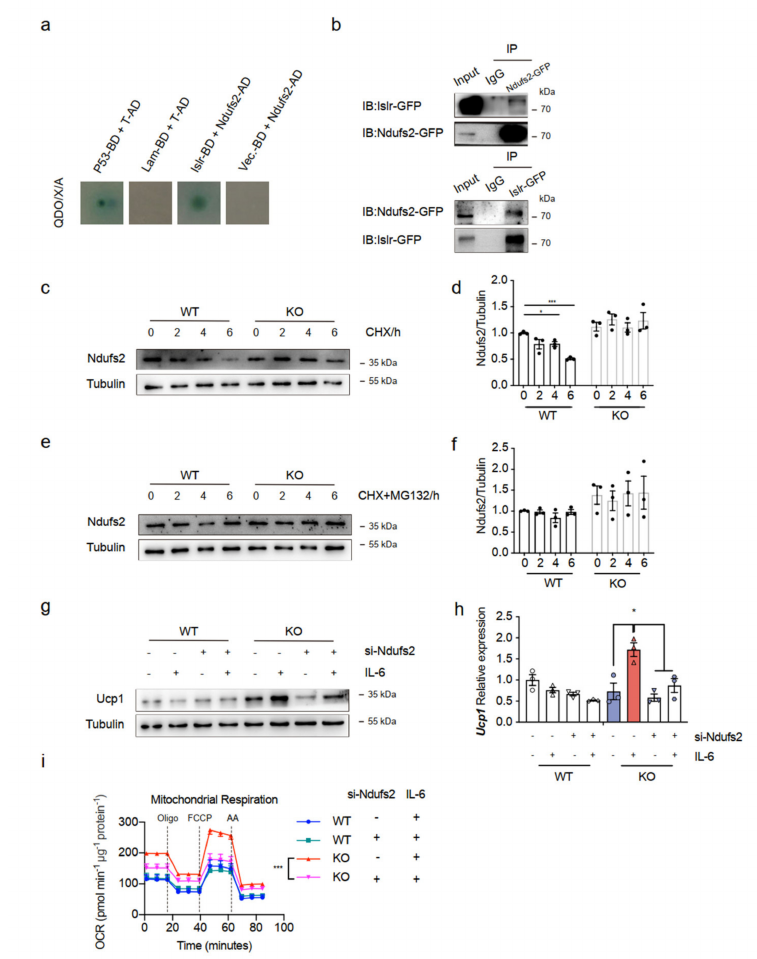
Figure 6. Ndufs2 directly interacts with Islr and is needed for IL-6-mediated thermogenesis: ( a ) Y2HGold cells were cotransformed with pGBKT7-Islr and pGADT7-Ndufs2 and plated on QDO/X/A plates; a blue color indicated a positive interaction. Cotransformation with pGBKT7-p53 and pGADT7-T was used as a positive control, cotransformation with pGBKT7-lam and pGADT7-T was used as a negative control, and cotransformation with pGADT7-Ndufs2 and pGADT7-T was used as a blank control; ( b ) reciprocal coimmunoprecipitation(co-IP) analysis of GFP-tagged Islr and GFP-tagged Ndufs2 in HEK293T cells; IB: immunoblotting; IP: immunoprecipitation; ( c , d ) Western blot analysis of Ndufs2 in WT and KO BATSVF treated with CHX for the indicated times ( c ); quantifi- cation of the Ndufs2 degradation rate by grayscale analysis ( d ); ( e , f ) Western blot analysis of Ndufs2 in WT and KO BATSVF treated with CHX+MG132 for the indicated times ( e ); quantification of the Ndufs2 degradation rate by grayscale analysis ( f ); ( g , h ) Western blot ( g ) and qPCR ( h ) analyses of Ucp1 in differentiated BATSVF (day 6) upon Ndufs2 siRNA or IL-6 treatment (n = 3); ( i ) OCR of differentiated BATSVF cells treated with Ndufs2 siRNA or IL-6; oligo, FCCP and AA were added at the time points indicated by dashed lines (n = 4). Error bars represent SEMs, * p < 0.05, *** p < 0.001, as determined by two-tailed Student’s t